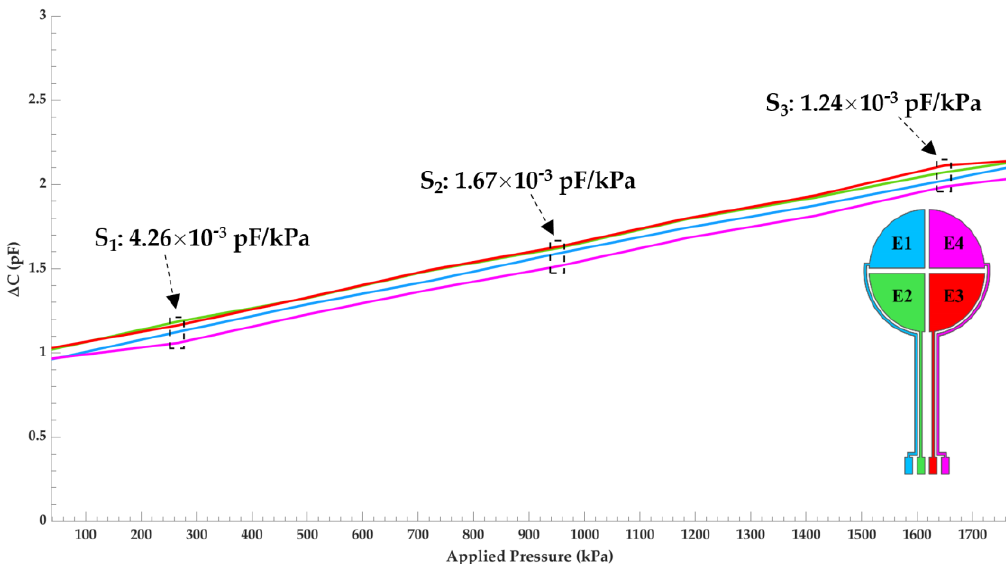
Figure 5. Capacitance change of the sensor as a function of pressure for each electrode. The plot is color coated to reflect the electrode’s location on the capacitive sensor’s schematic.